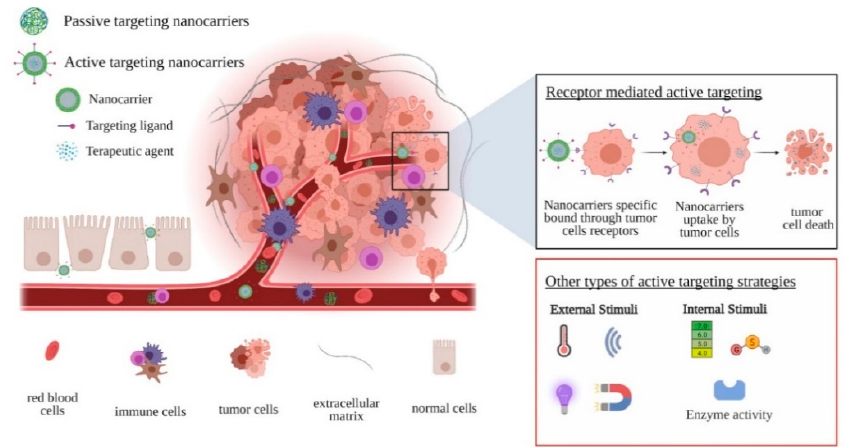
Figure 2. Schematic representation of drug-delivery systems targeting